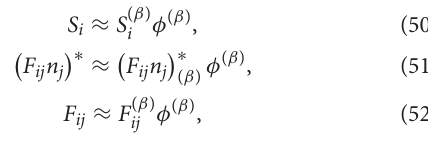
of all faces is denoted E